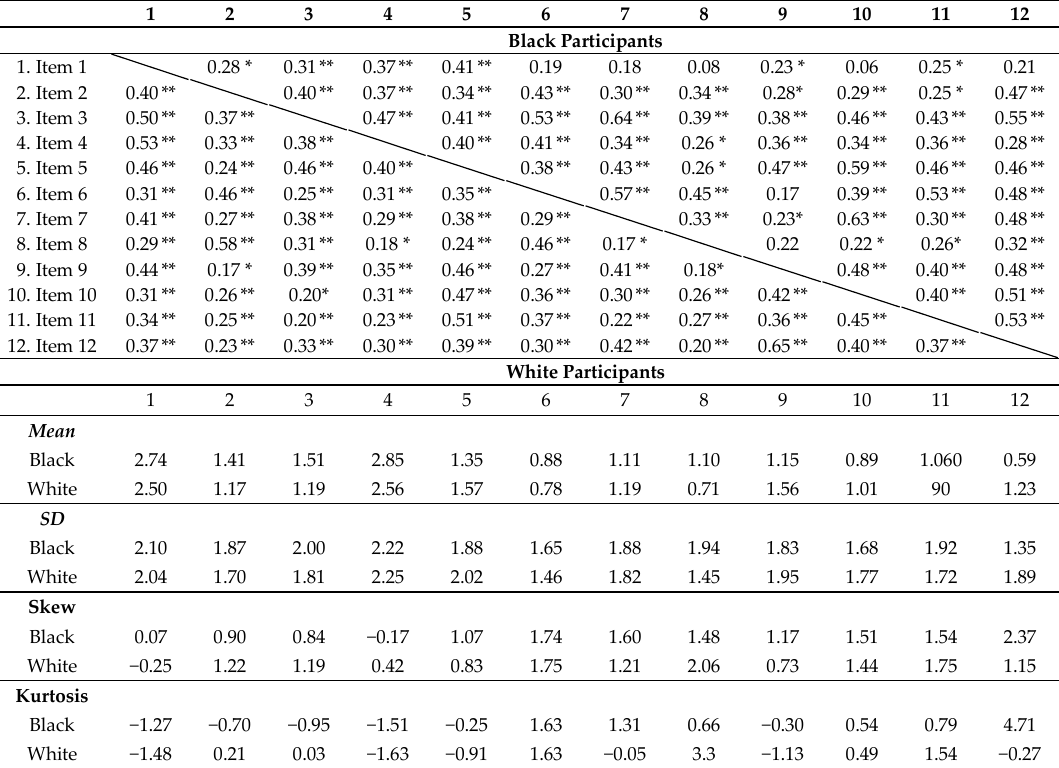
Table 2. Correlation coefficients, descriptive statistics, and normality estimates for Prime Screen items.